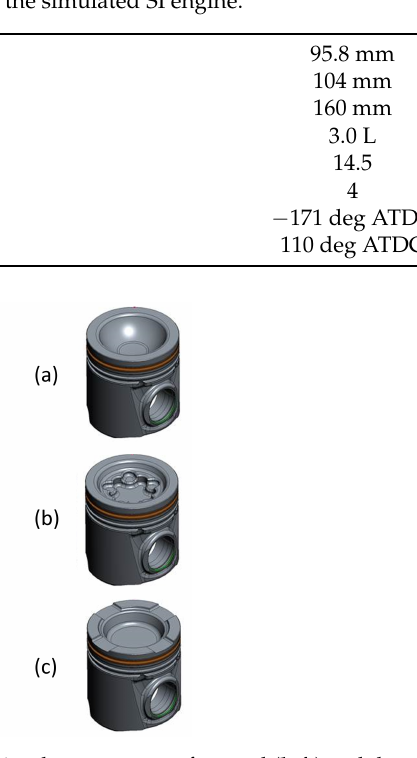
Figure 4. Different piston bowl geometries that were manufactured ( left ) and those from the software program ( right ): original piston ( a ), star piston ( b ), and tower piston ( c